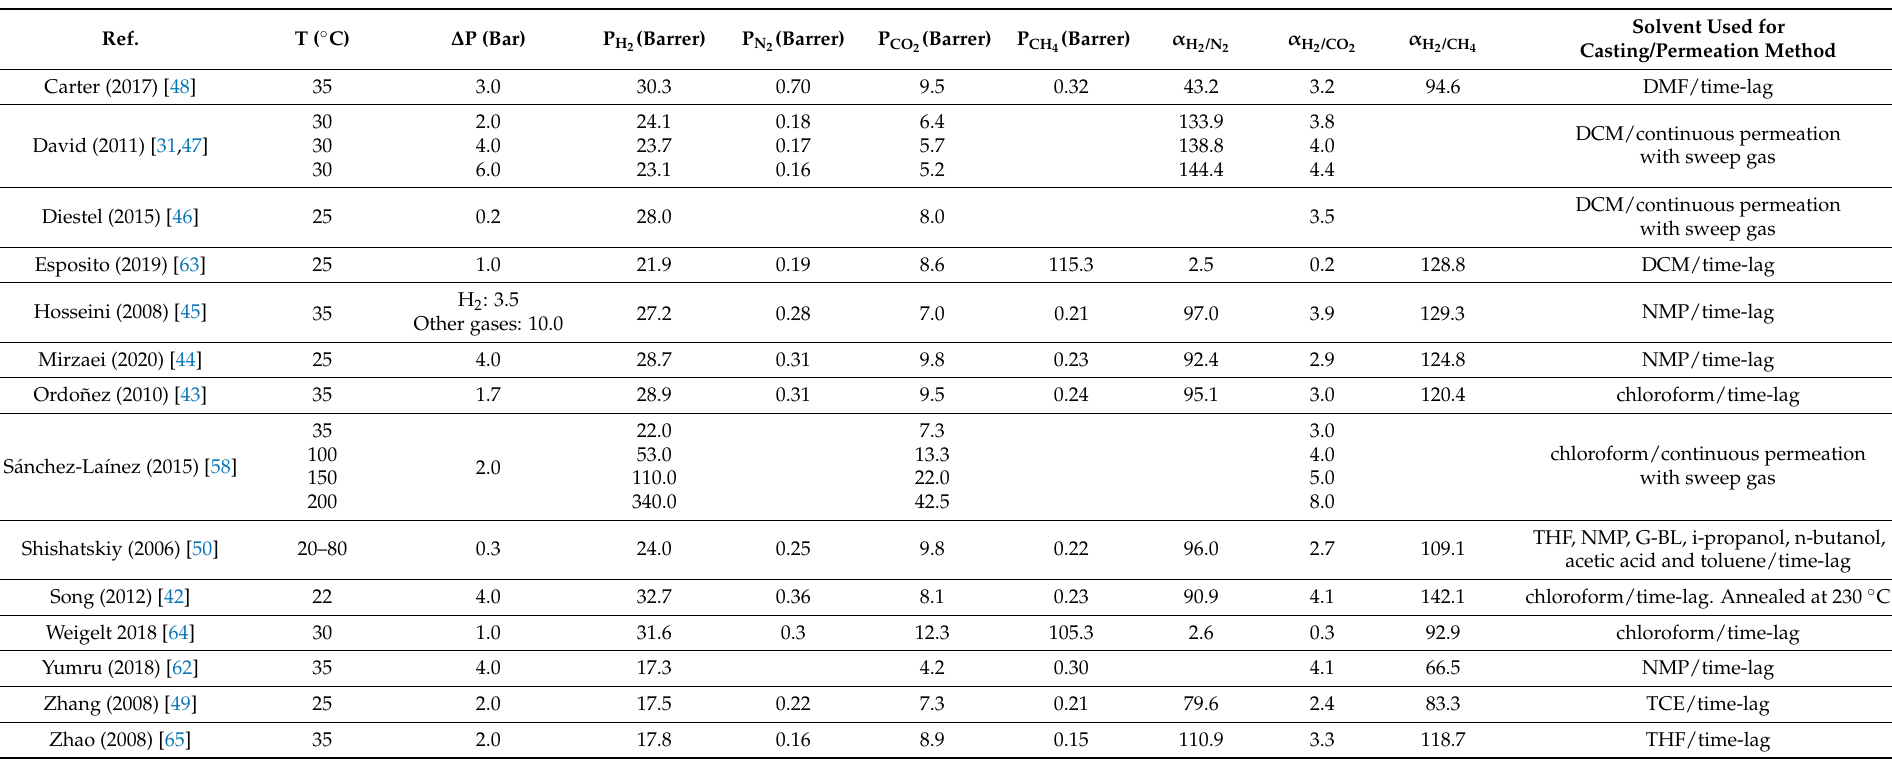
Table 2. Main bibliographical data in terms of pure gas H 2 , N 2 , CO 2 and CH 4 permeabilities and selectivities through pristine Matrimid ® membrane.